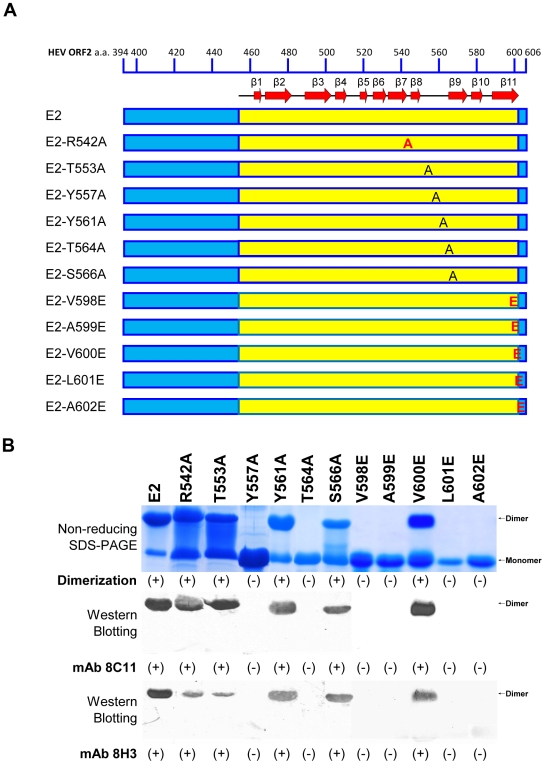
Mutational studies on the dimer interface.
(A) The schematic representation of wild-type E2 and eleven point mutations targeting the dimer interface region. Secondary structural elements are shown for the E2s region. The mutated residues located on the β-strands and coils are shown in red and black, respectively. (B) These mutants and wild-type E2 were subjected to non-reducing SDS-PAGE and Western Blotting with the neutralizing mAb 8C11 and 8H3 to study the effects of these mutations on dimerization and neutralization, respectively. [+] denotes dimerization or reactivity with 8C11 or 8H3, [−] denotes loss of the respective property. Note that both the capacity to form dimers and the reactivity with mAb 8C11 and 8H3 were abolished simultaneously in six of these mutants: Y557A, T564A, V598E, A599E, L601E and A602E.